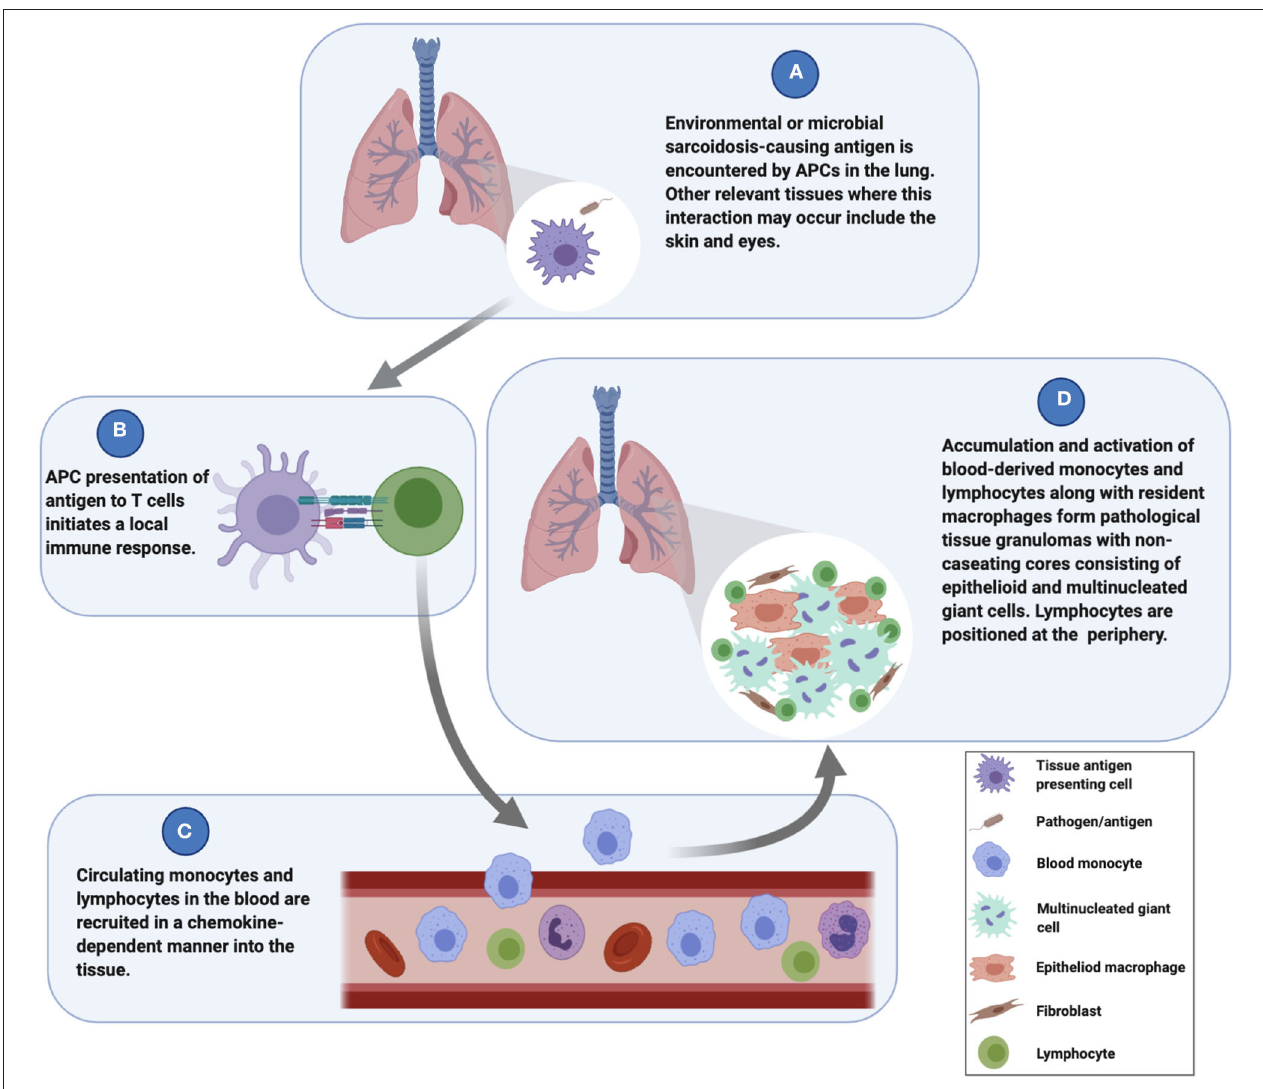
FIGURE 1 | Mechanisms underlying the initiation and evolution of sarcoidosis granuloma formation.